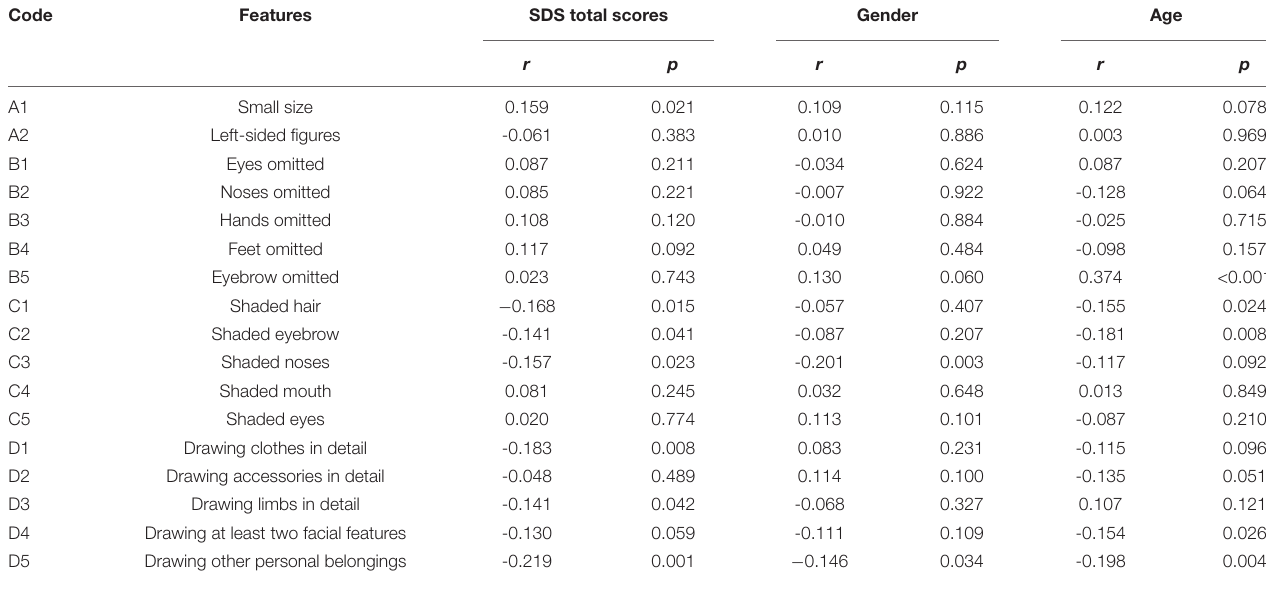
TABLE 2 | Correlation between SDS total scores, gender, and age with drawing